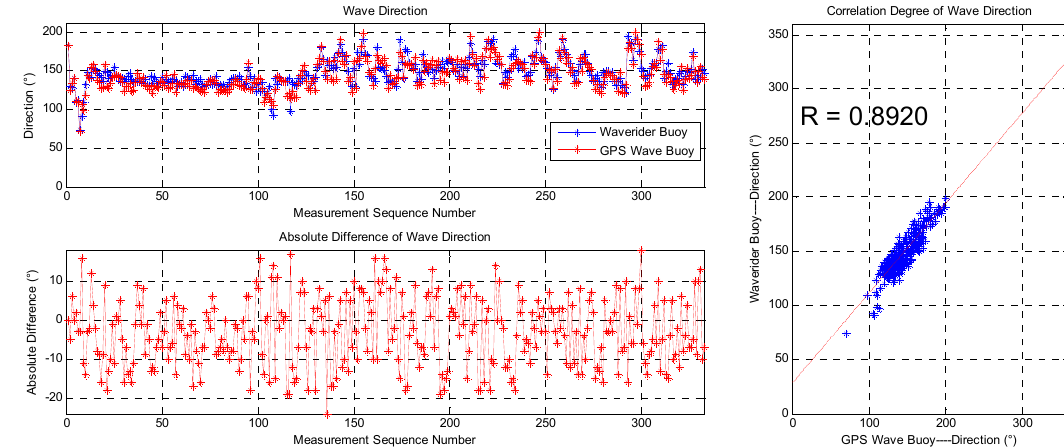
Figure 17. Comparison of wave directions between the SBF7-1A GPS wave buoy and the DWR-MKIII Waverider buoy after correction.